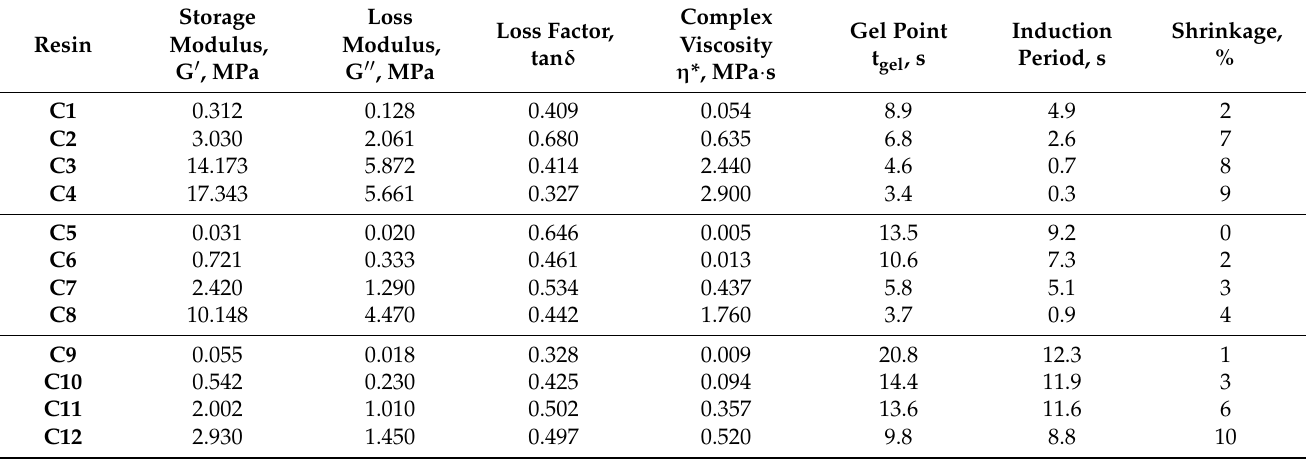
Table 2. Rheological Characteristics of